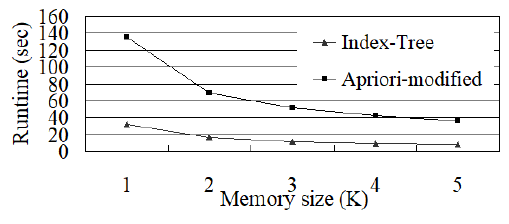
Fig. 17 Runtime vs. memory size ( d = 10K, n = 100, m = 5%, s =